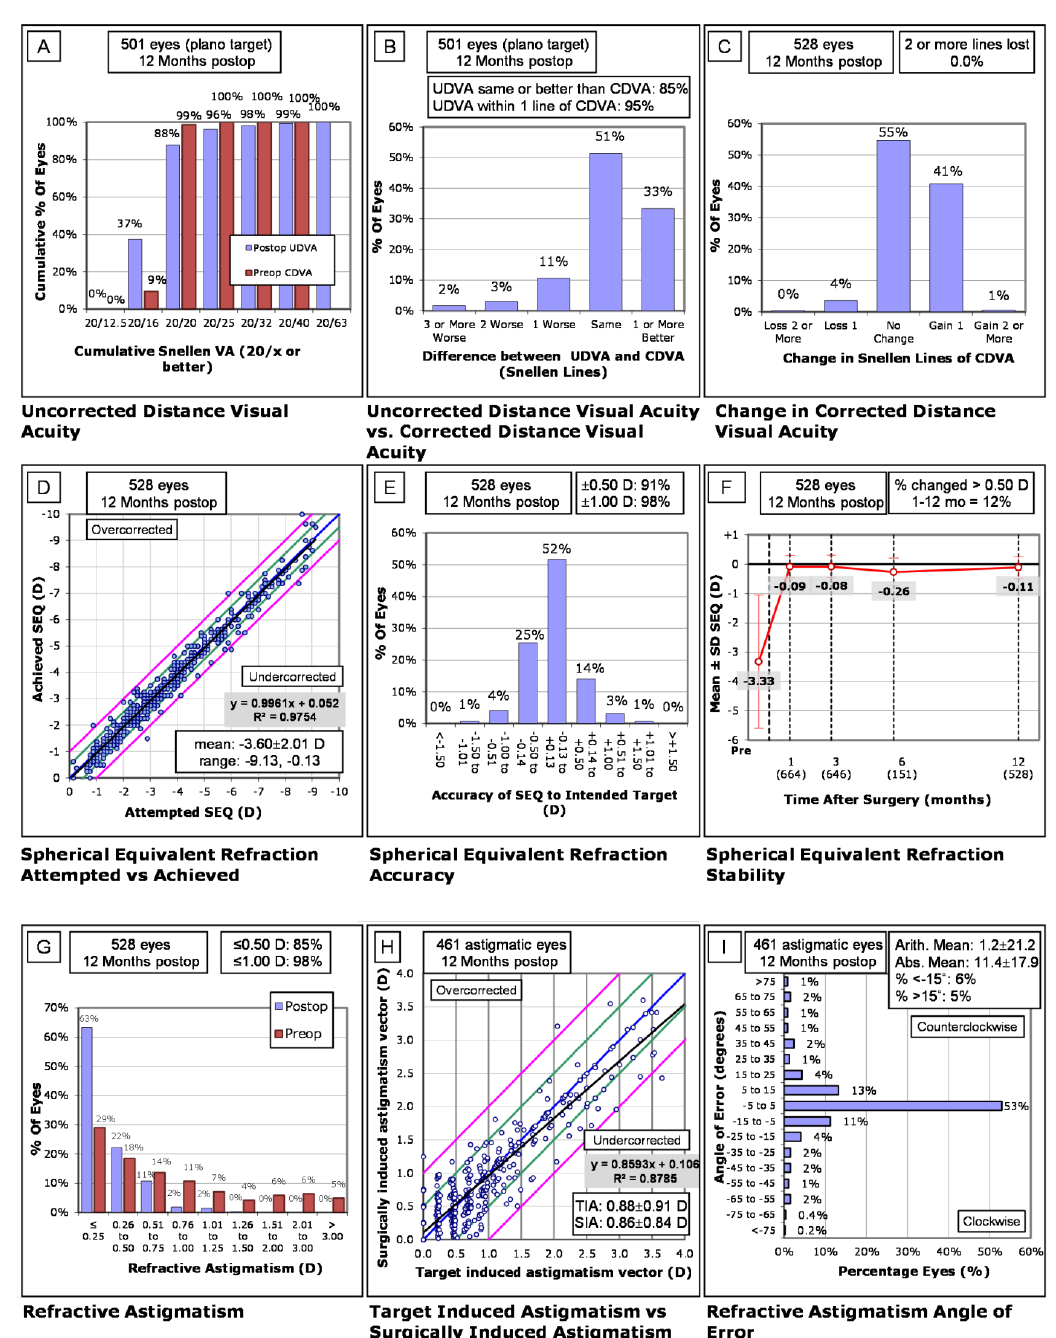
Figure 3. Analysis of DLK patients at 12 months postoperatively. ( A – I ) Standard graphs for refractive surgery shown above. ( A ) Uncorrected distance visual acuity (UDVA) at 12 months. ( B ) The difference in UDVA and corrected distance visual acuity (CDVA) at 12 months postoperatively. ( C ) Change in postoperative CDVA compared with preoperative CDVA. ( D ) Comparison of the attempted refractive spherical equivalent (SEQ) with the achieved refractive SEQ. ( E ) The accuracy of the attempted SEQ with the achieved SEQ. ( F ) Stability of the refractive SEQ postoperatively over 12 months. ( G ) Refractive astigmatism. ( H ) Target induced astigmatism (TIA) versus surgically induced astigmatism (SIA). ( I ) The angle of error of refractive astigmatism at 12 months